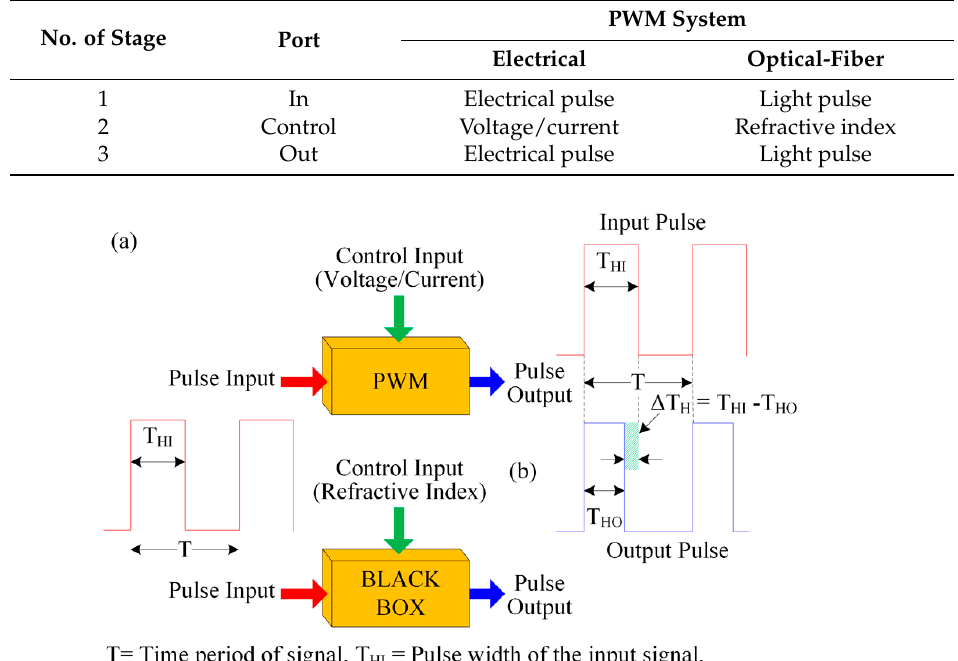
Figure 2. Functional analogy between the two PWM systems: ( a ) electrical; and ( b ) optical-fiber PWM sensing systems.